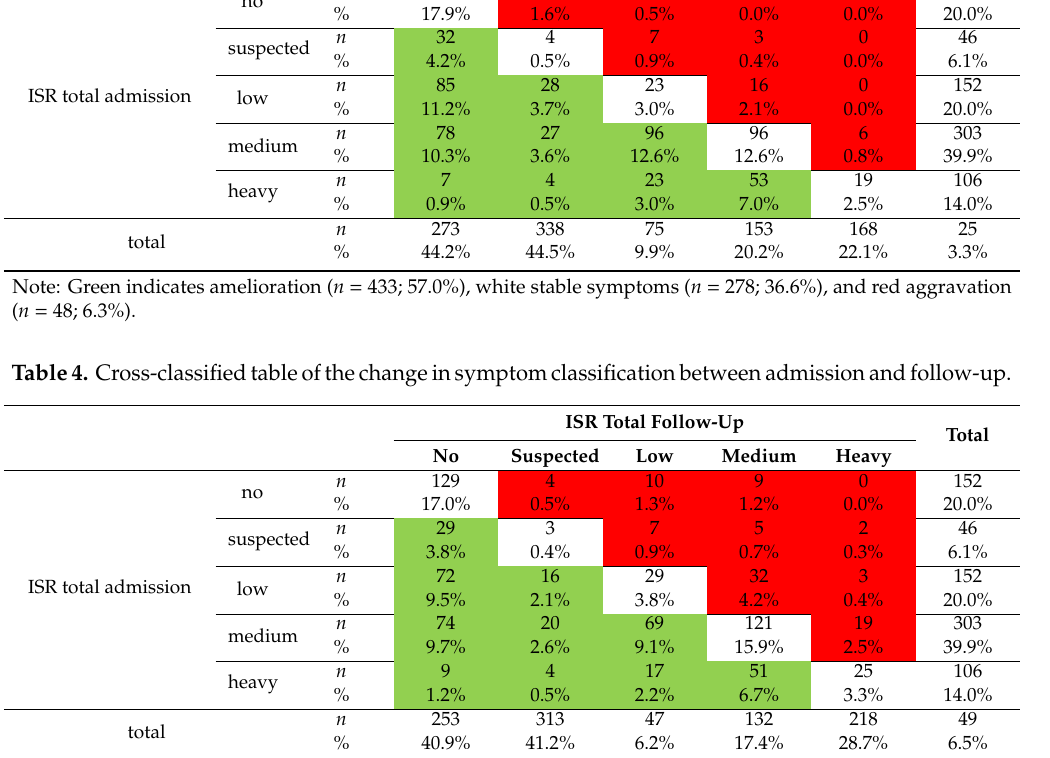
ISR Total Discharge Total No. Suspected Low Medium